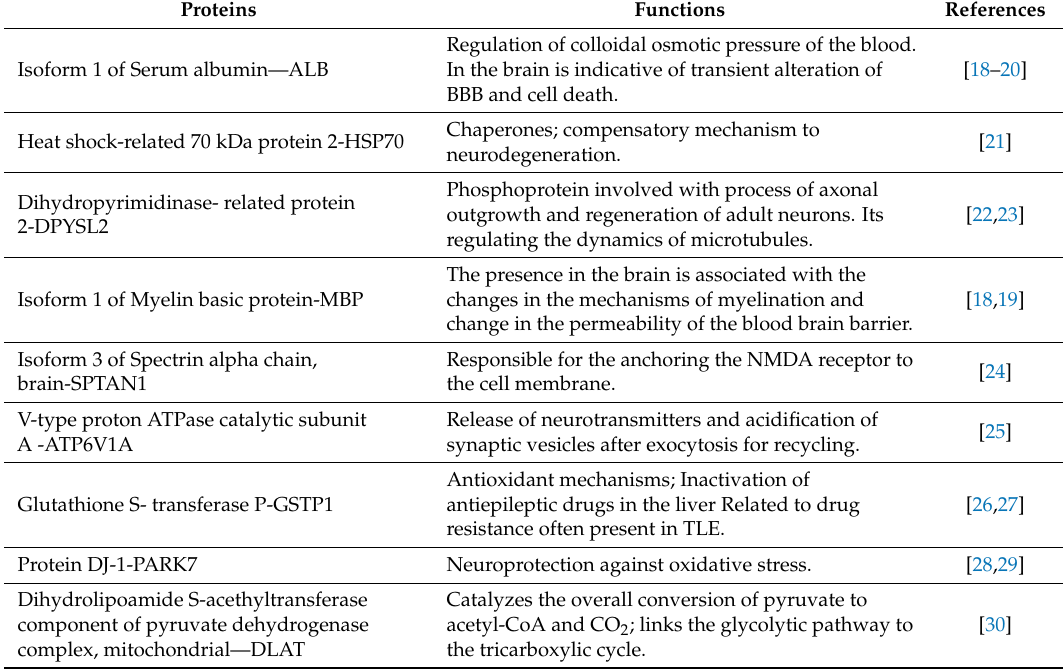
Table 2. Cellular and molecular functions of proteins identified in MTLE using proteomic analysis.